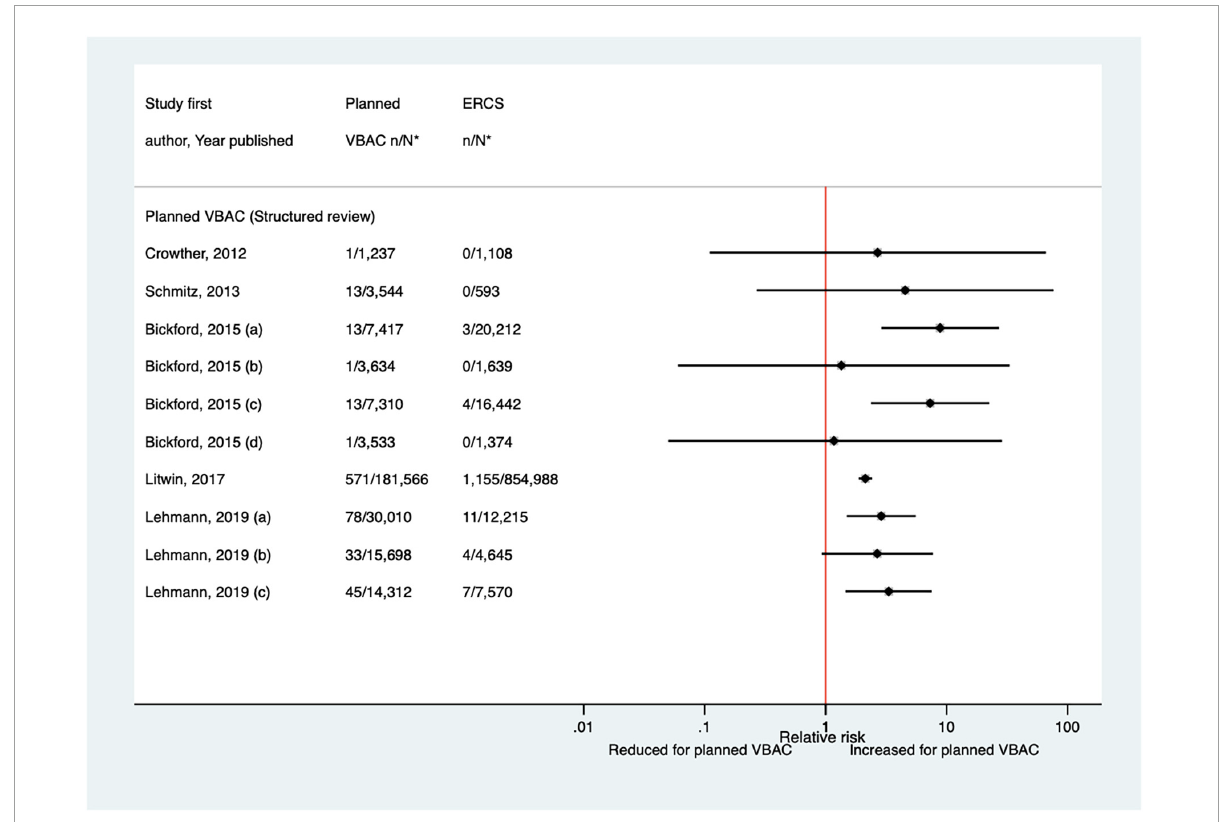
FIGURE15 Risk of Apgar score < 4 at 5 min after birth for planned VBAC vs. ERCS. * n , number in group with the outcome; N , Total number in group. Bickford and Janssen (50) (a) risk in women with 1–2 prior CSs only, (b) risk in women with 1–2 prior CSs and ≥ 1 prior VB, (c) risk in women with 1 prior CS only, (d) risk in women with 1 prior CS and ≥ 1 prior VB; Lehmann et al. (67) (a) risk in all of study population, (b) risk in “low-risk” women, (c) risk in “high-risk” women. CS, cesarean section; ERCS, elective repeat cesarean section; VBAC, vaginal birth after previous cesarean; VB, vaginal